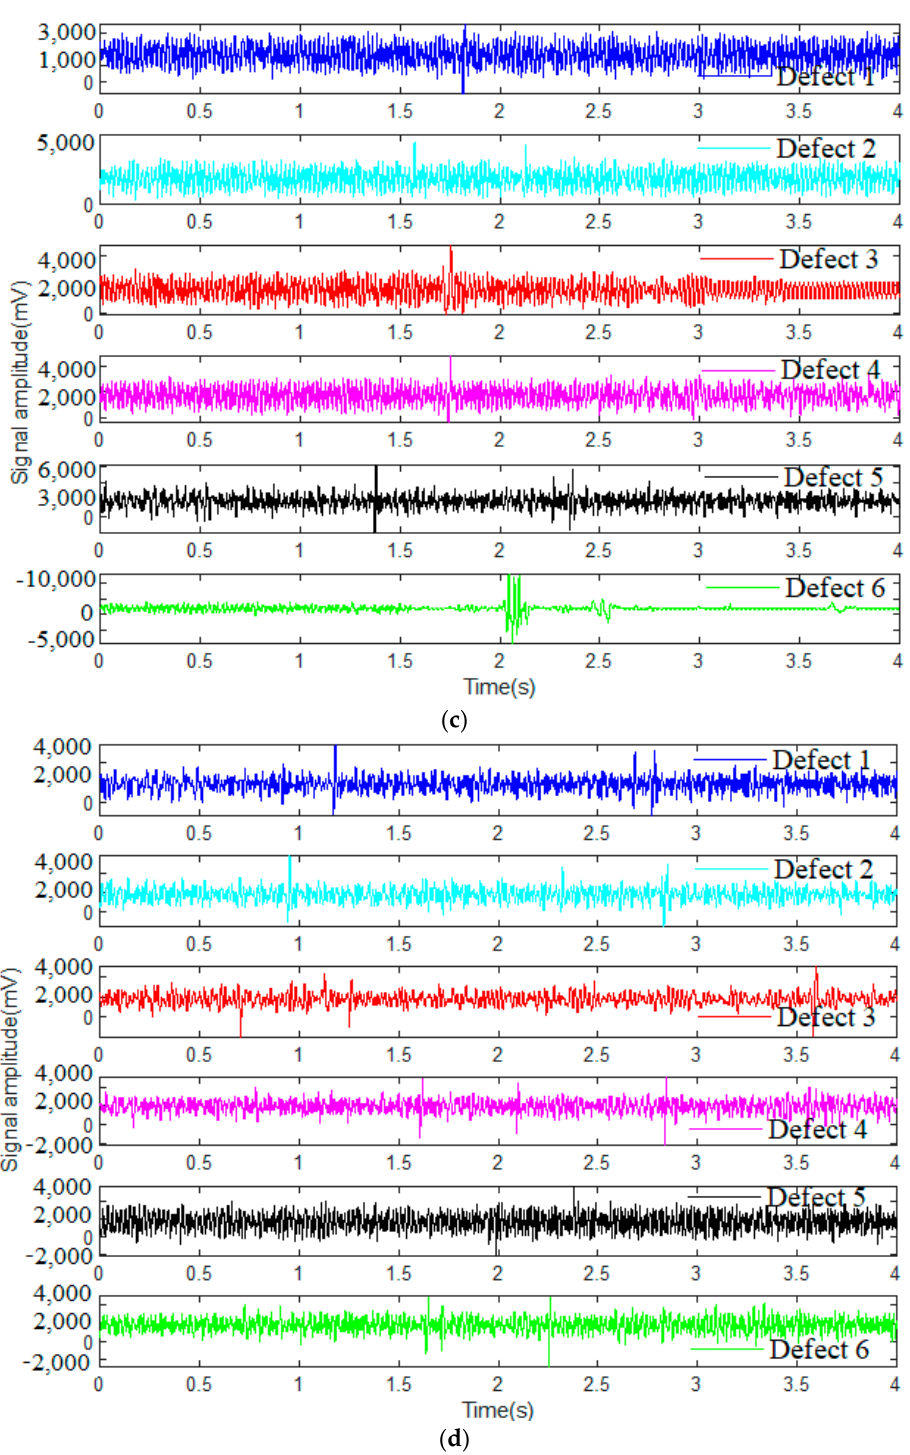
Figure 2. Wire rope detection signals from different datasets: ( a ) wire rope detection signal of dataset 1; ( b ) wire rope detection signal of dataset 2; ( c ) wire rope detection signal of dataset 3; and ( d ) wire rope detection signal of dataset 4.